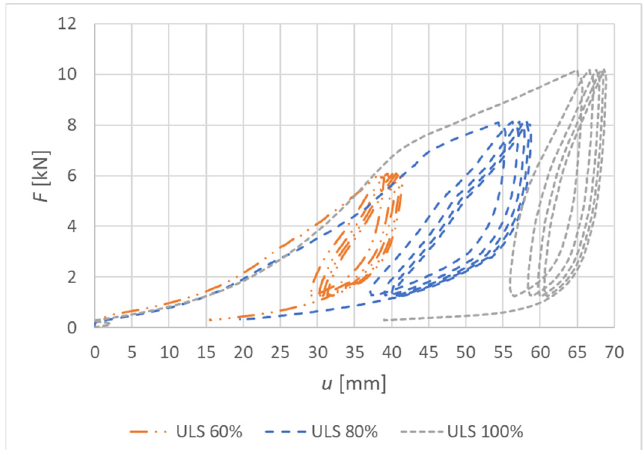
Figure 19. Load–deformation curves of nondestructive quasi-static cyclic testing for individual specimens made from fully threaded screws (Experiment B).